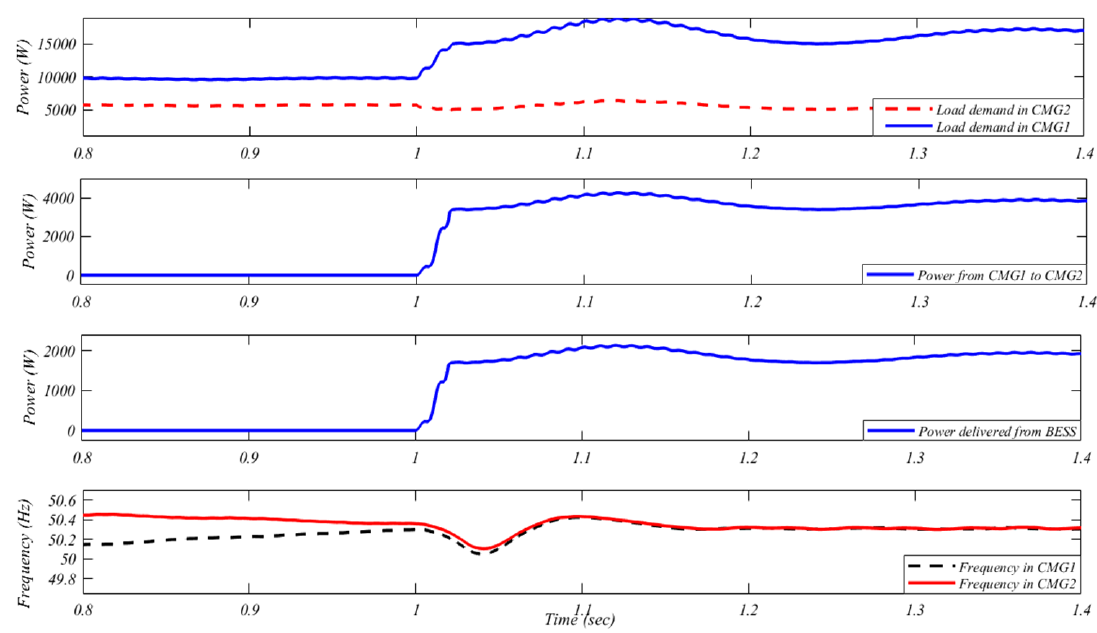
Figure 7. Active power and frequency in interconnected condition when CMG 1 is overloaded.